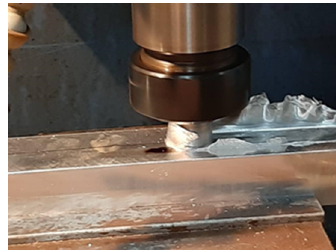
Figure 3. FSP of recycled AA 6063.